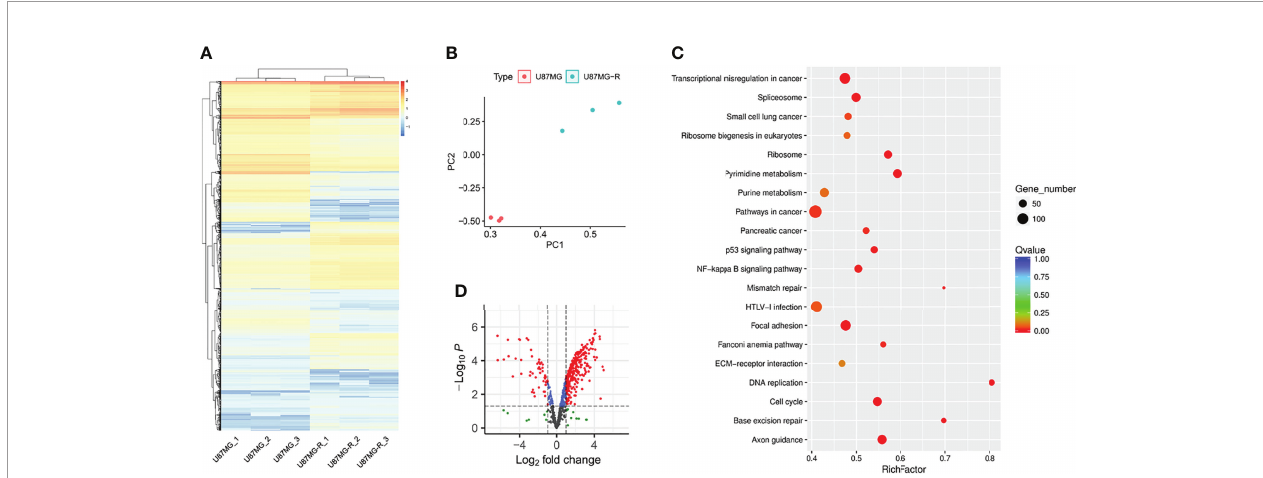
FIGURE 1 | DDR was enriched in TMZ-resistant glioma cells. (A) The heatmap presented the gene expression pro fi ling of U87-MG and U87-MGR cells. (B) PCA distinguished the U87-MG and U87-MGR cells. (C) The differentially enriched KEGG pathways between U87-MG and U87-MGR cells. (D) The volcano plot showed the distribution of DDR-related DEGs between U87-MG and U87-MGR